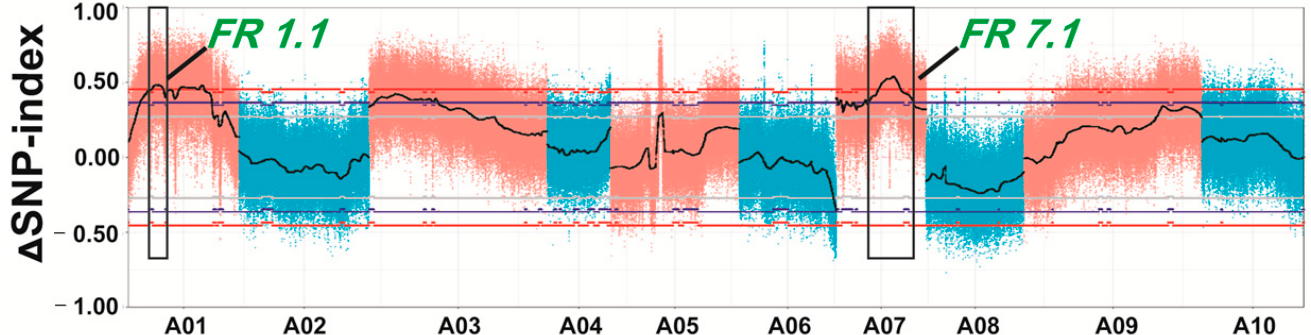
Figure 4. The ∆ (SNP-index) graph of two extreme pools. The black line is the average value of ∆ (SNP-index) in a sliding window of 1 Mb. Blue and red lines represent statistical confidence intervals p < 0.1 and p < 0.05, respectively. Two regions on chromosome A01 and A07 (black box) were identified.